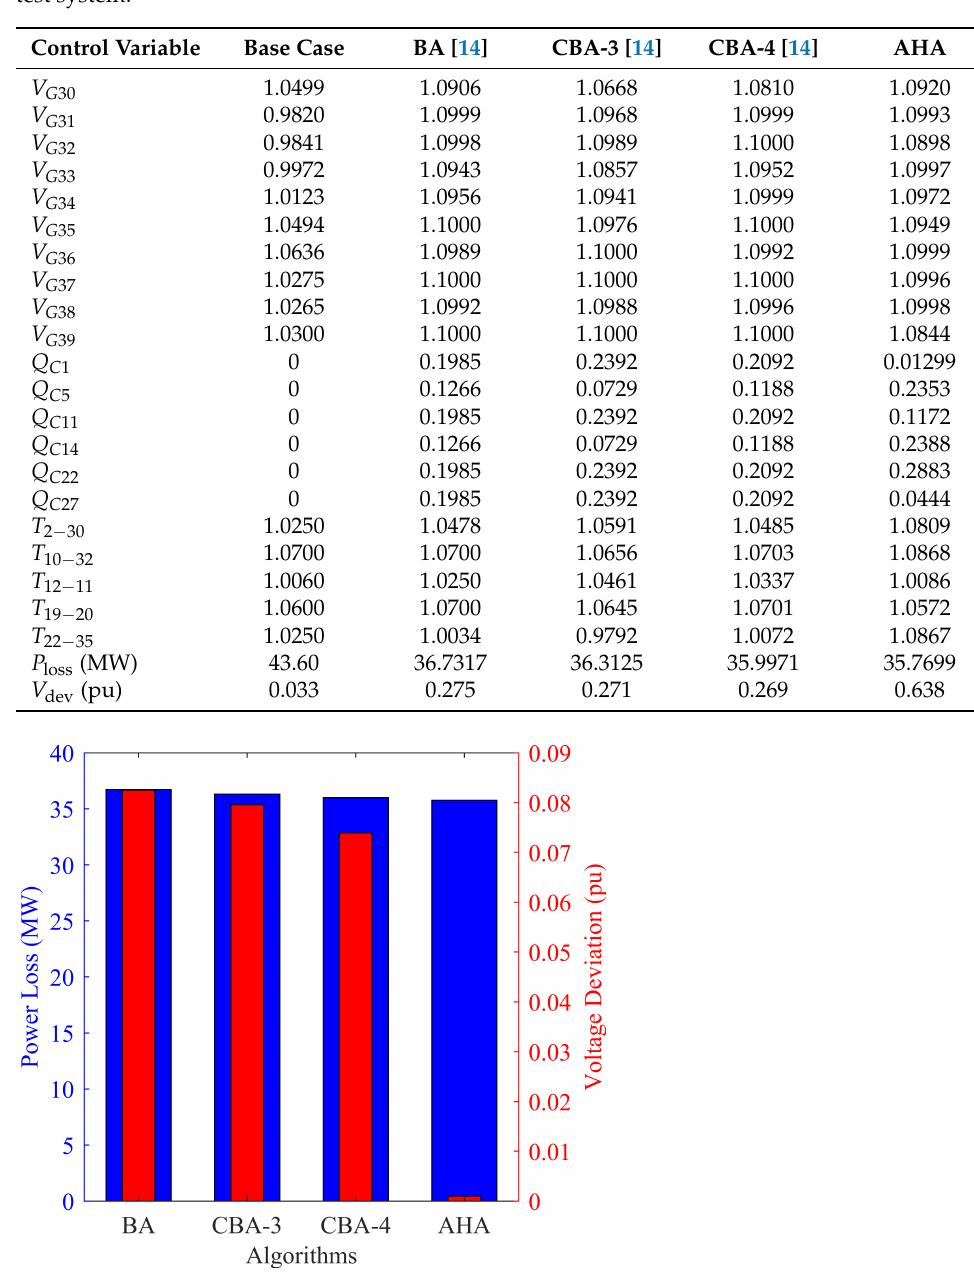
Table 7. Optimal values of control variables with P loss as an objective function for the IEEE 39 bus test system.